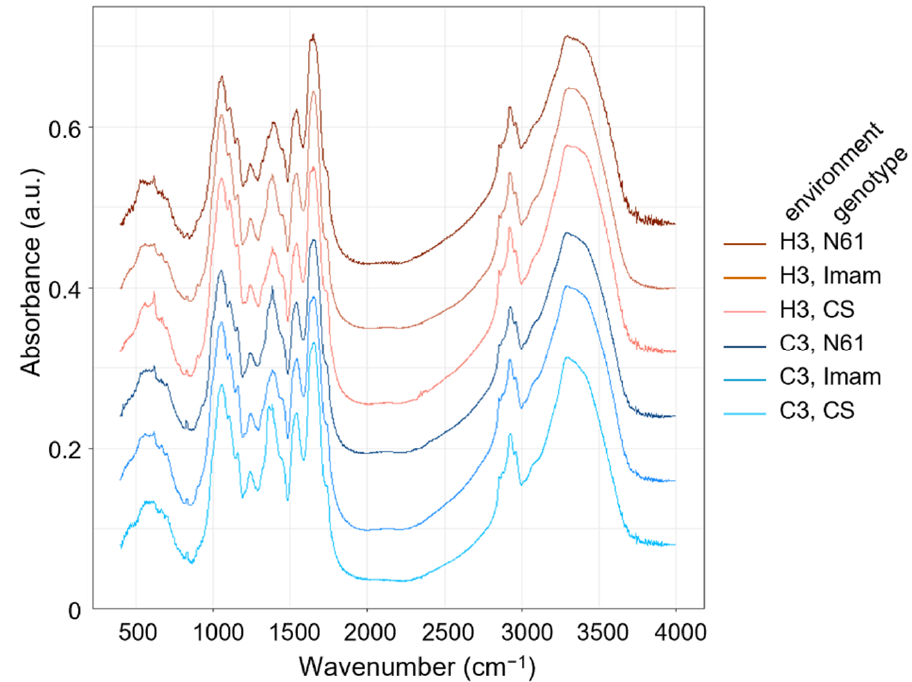
Figure 2. Representative FTIR spectra in the leaves of wheat genotypes Chinese Spring (CS), Imam, and Norin 61 (N61). Spectra drawn in blue and red color series represent those for control (C3) and heat stress environments (H3), respectively.